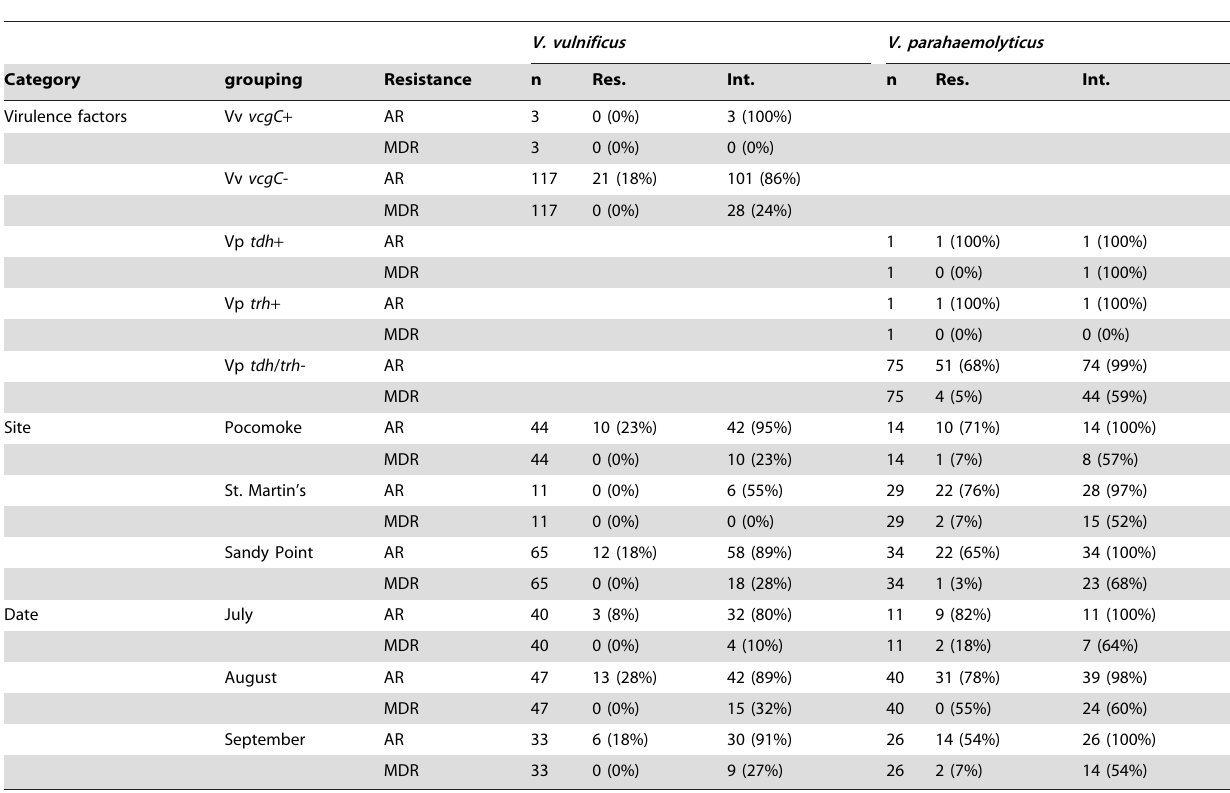
Table 6. Antibiotic resistance (AR), defined as resistance to any one antibiotic, and multi-drug resistance (MDR), defined as resistance to two or more antibiotic classes, by virulence factors (6A), site (6B) and month (6C) for V. vulnificus and V. parahaemolyticus